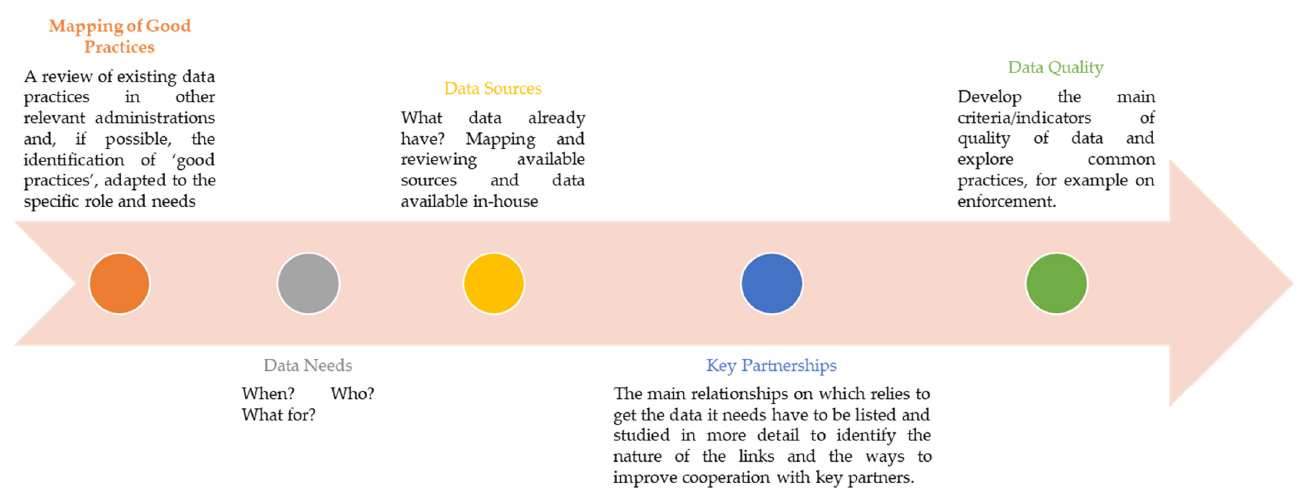
Figure 4. Data collection